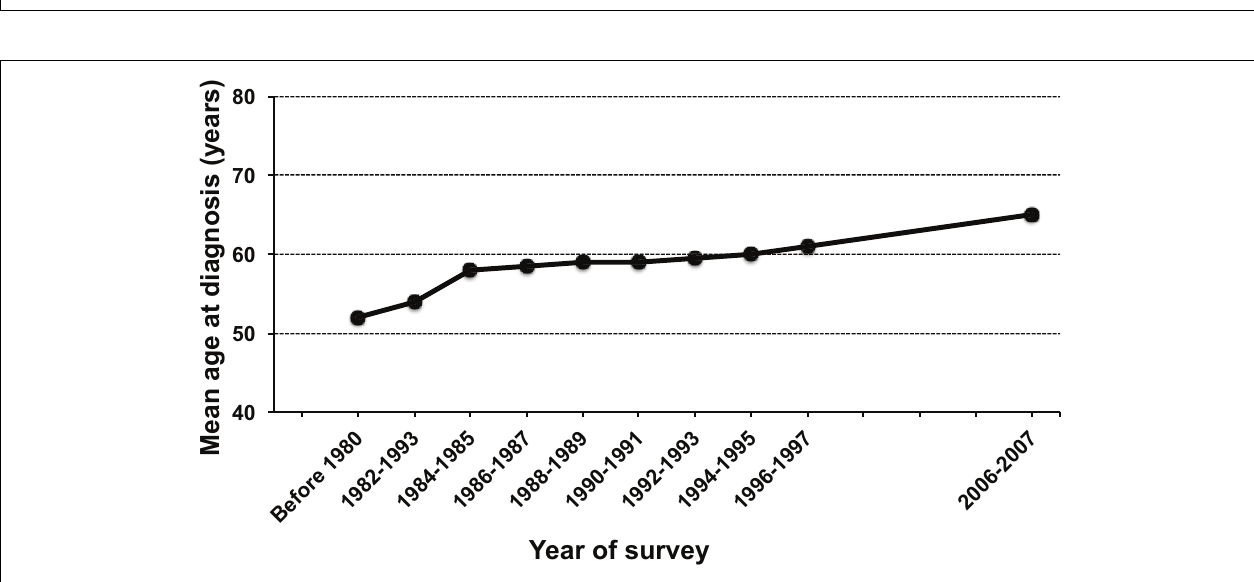
FIGURE 2 | Chronological changes in the mean age at diagnosis of adultT-cell leukemia (ATL) in Japan. The figure was modified from Figure 2 inYamada et al. (2011).